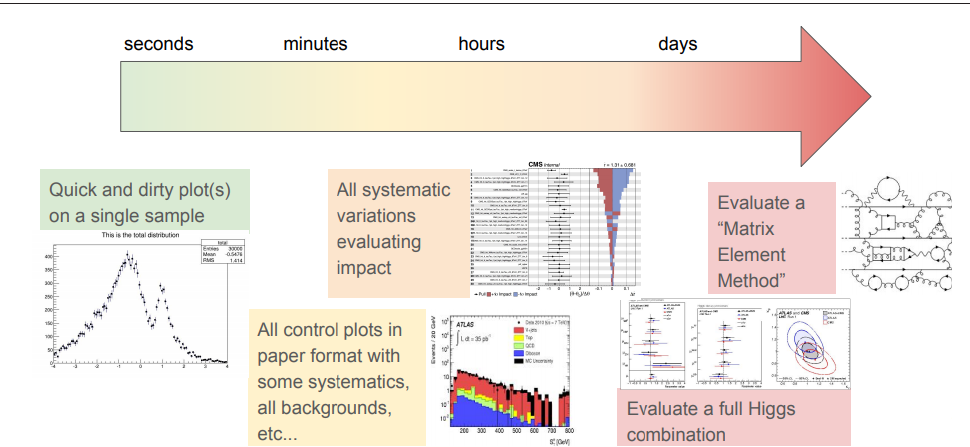
Figure 2. CPU time needed for di ff erent analysis level processing tasks: single histograms can typically be filled at multi KHz rate while on the other extreme Matrix Element Method for event classification can have sub-Hz